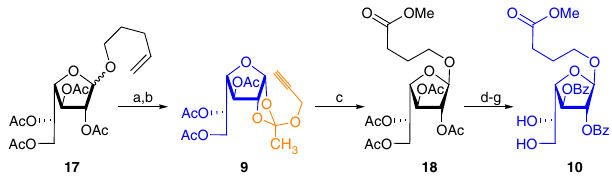
Figure 4 | Synthesis of Galactofuranoside-building blocks. Reagents and conditions: (a) Br 2 , CH 2 Cl 2 , 4Å MS, 0 (cid:2) C, 15min. (b) Propargyl alcohol, 2,6-lutidine CH 2 Cl 2 , 4Å MS 0 (cid:2) C - 25 (cid:2) C, 10h, 81% over two steps. (c) Methyl 4-hydroxybutanoate, AuCl 3 , 4Å MS, CH 2 Cl 2 , 25 (cid:2) C, 2h, 80%. (d) NaOMe, MeOH, 25 (cid:2) C, 15h. (e) 2-Methoxypropene, acetone, PTSA, 8h. (f) BzCl, py., 0 - 25 (cid:2) C. (g) PTSA, MeOH, 25 (cid:2) C, 4h, 70% over four steps.